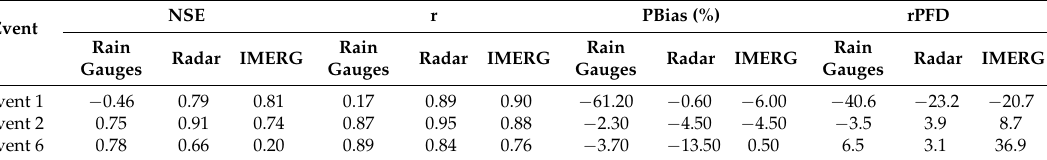
Table 7. The results of the evaluation criteria for calibration events.